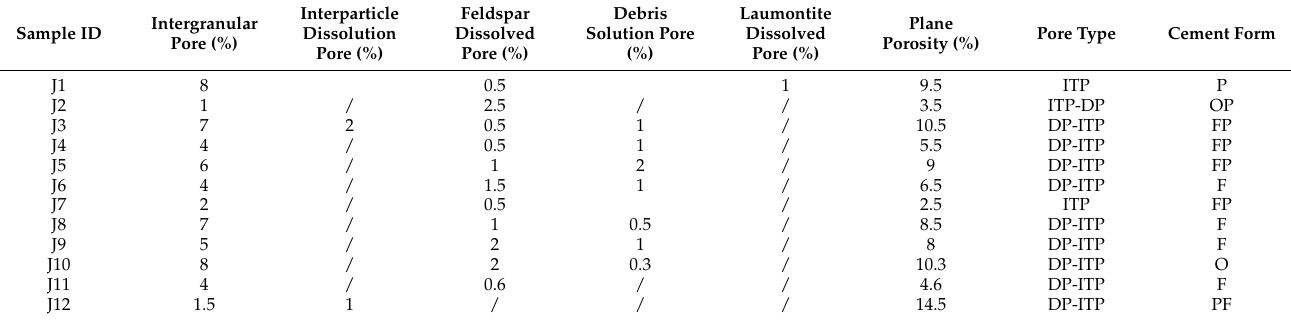
Table 2. The CTS results of the 12 typical